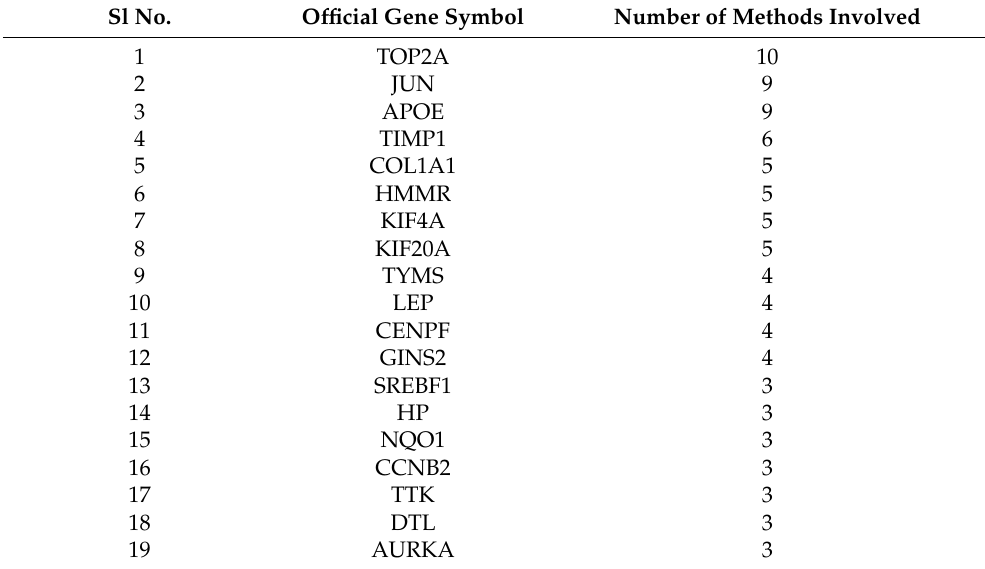
Table 1. Hub gene analysis with cytoHubba plug-in to identify the top candidate genes. Sl No. Official Gene Symbol Number of Methods Involved